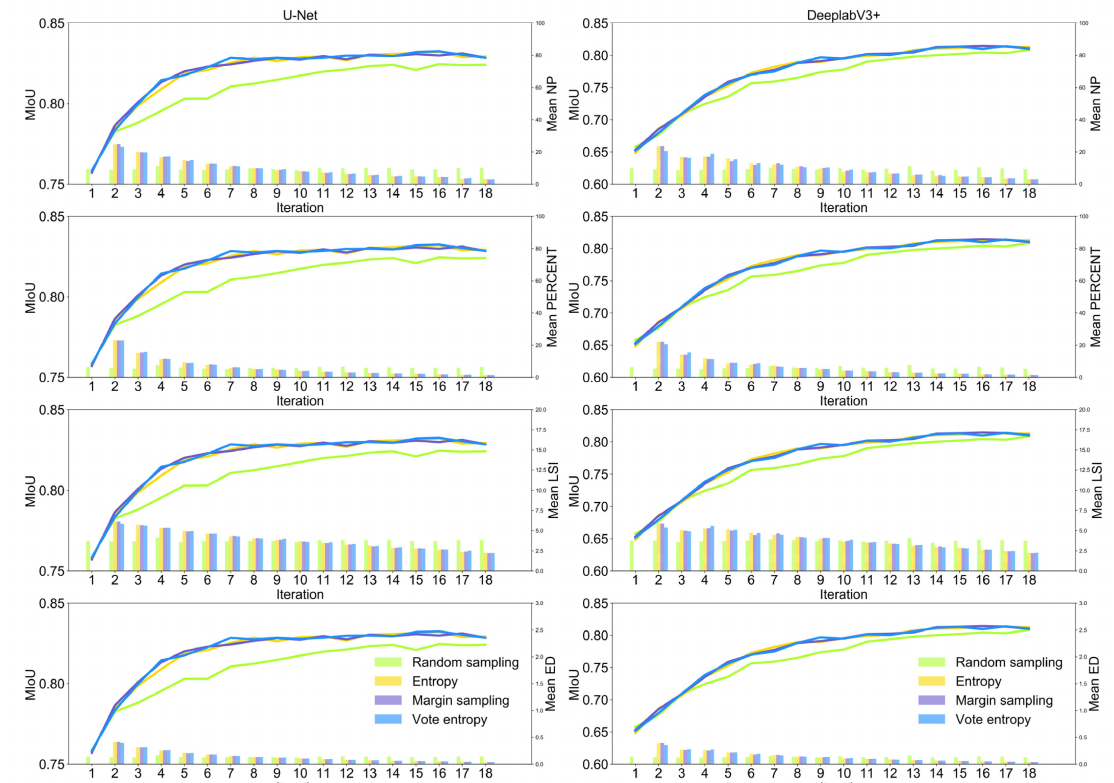
Figure 6. Landscape patterns of selected tiles in each iteration via three active learning strategies and random sampling from WHU satellite dataset II. The x -axis indicates the iterations of model training. The left y -axis indicates the value of mIoU in each iteration. The right y -axis indicates the value of the landscape metrics computed based on selected image tiles in each